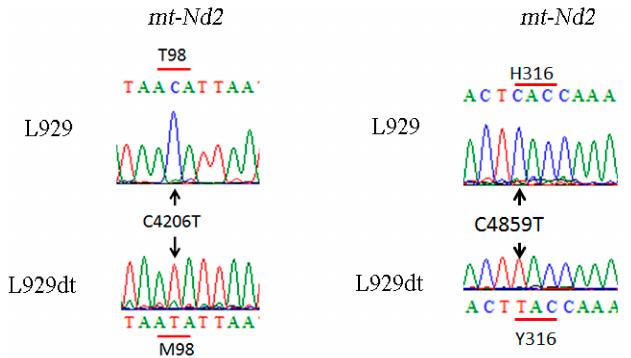
Figure 6. Characterization of complex I mtDNA mutations. Chromatograms showing the m.4206C > T and the m.4859C > T mutations within the mt-Nd2 gene in L929dt